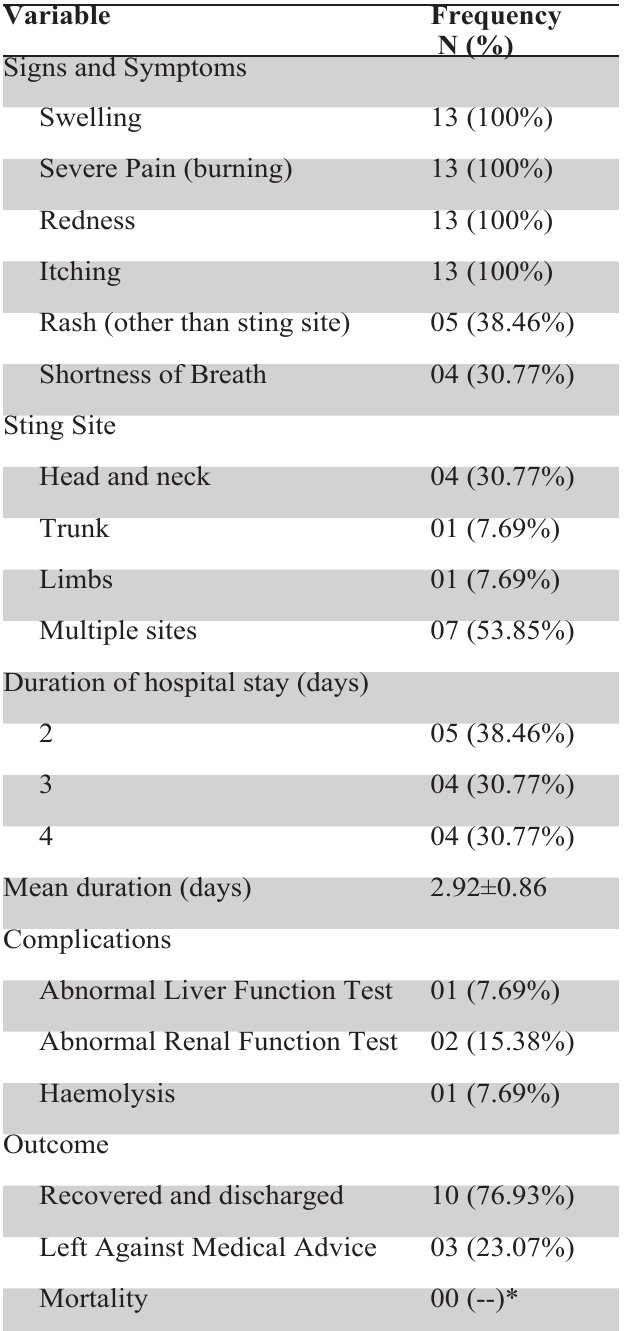
Table 2. Clinical presentation and outcome.